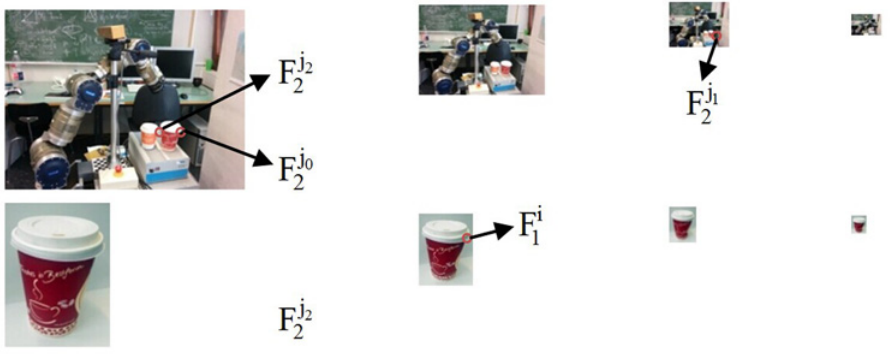
Fig 5. Searching the second nearest feature in the limiting area.